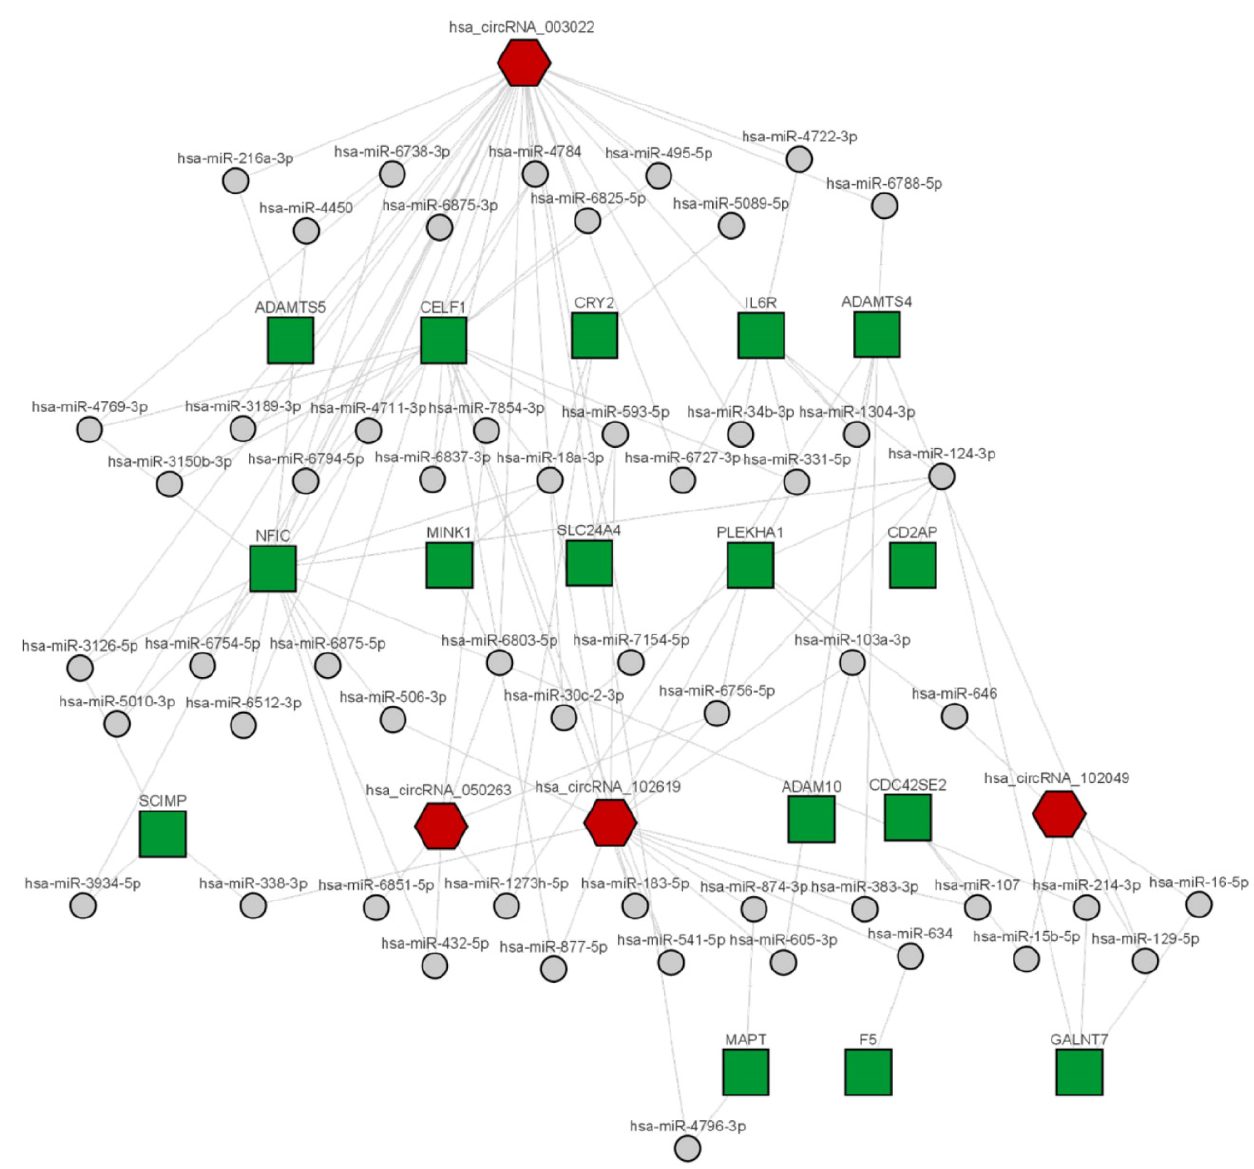
Figure 8. Network of circRNA-miRNA-mRNA for selected targets. CircRNAs are represented as red hexagons, miRNAs as grey dots, and mRNAs as green squares.